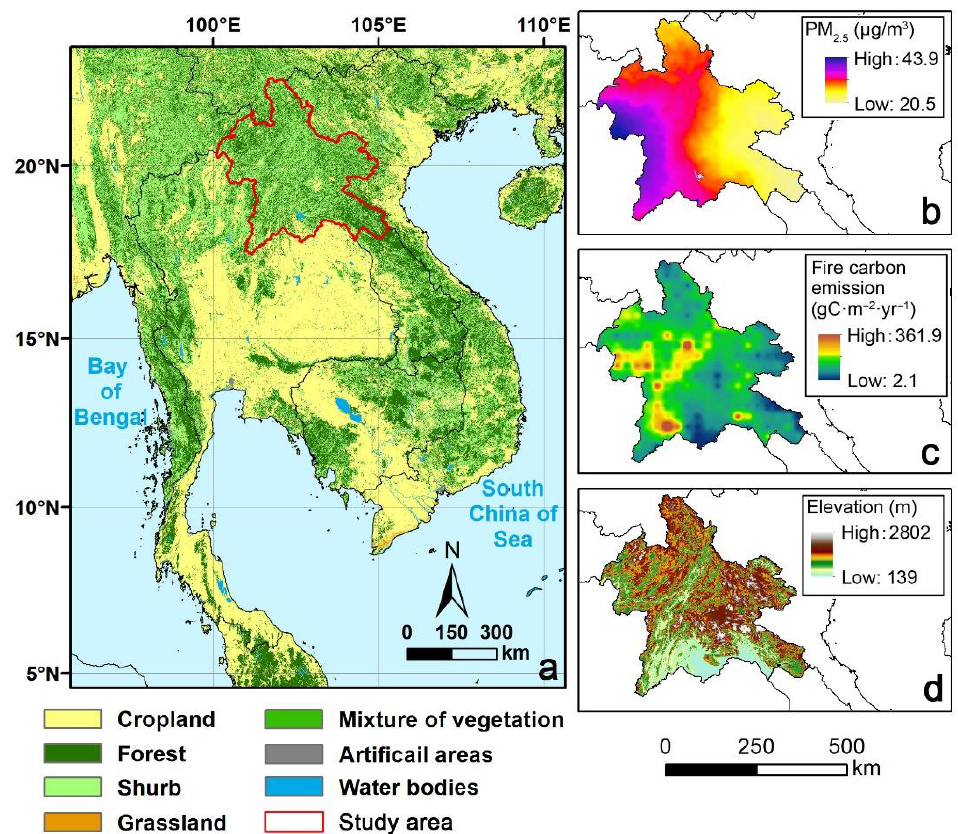
Figure 1. Study area. ( a – d ) Vegetation types, PM 2.5 (average from 2003 to 2019), fire carbon emission (average from 2003 to 2019), and altitude distribution map in the study area,